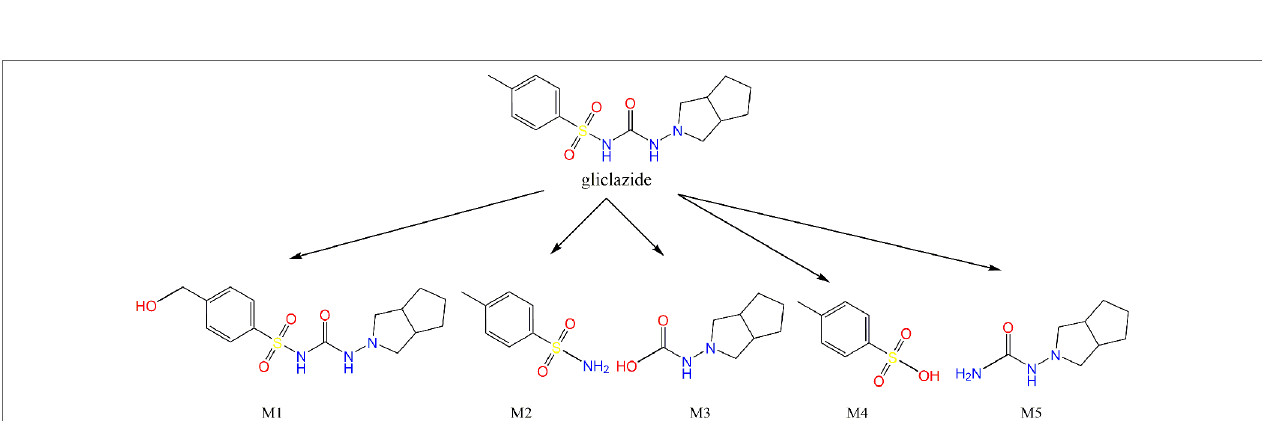
FIGURE 5 | Plot of MetaPrint2D predictions. The atoms in the gliclazide molecule, which are most likely to be metabolized, as well as the reactions that potentially can take place are marked. NOR indicates the normalized occurrence ratio; a high NOR indicates a more frequently reported site of metabolism in the metabolite